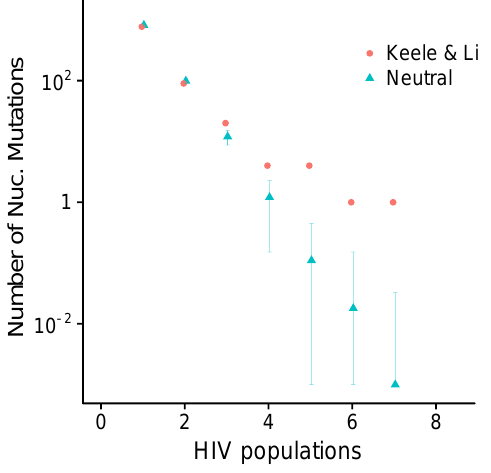
Figure 1. Convergent mutations are unusually frequent during early infection of HIV-1. Comparison between nucleotide mutations observed in one or more HIV-1 populations. Each HIV-1 population is isolated from a different infected individual. The Keele and Li data is compared to a neutral model of the same number of mutations as observed for each HIV-1 population using the same substitution rates as measured from the Keele and Li data. Data generated under the neutral model show the mean and standard deviations of 1000